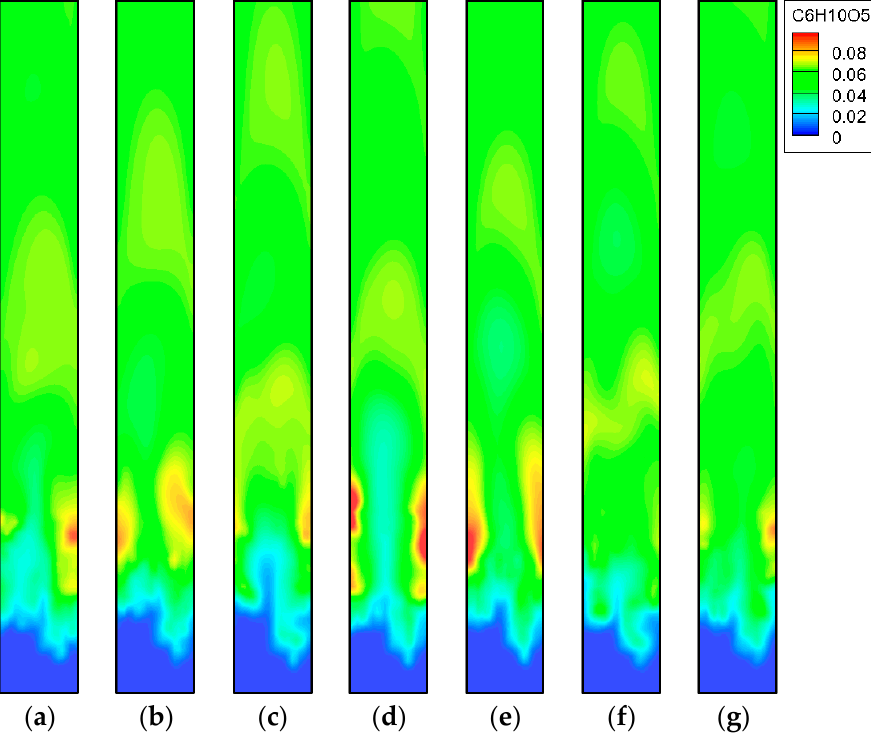
Figure 7. LVG mass fractions. ( a ) 9 s, ( b ) 9.1 s, ( c ) 9.2 s, ( d ) 9.3 s, ( e ) 9.4 s, ( f ) 9.5 s, and ( g ) 9.6 s.